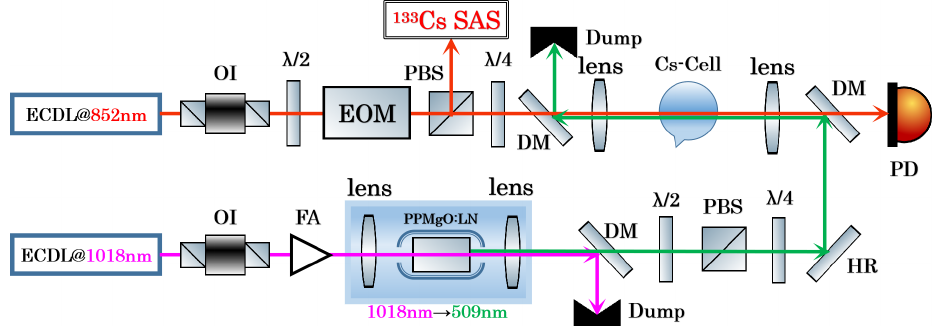
Figure 1. Schematic diagram of the experimental setup.An ECDL at 852 nm is used as a probe laser, and an ECDL at 1018 nm is frequency-doubled and used as a 509-nm coupling laser. The frequency-doubling crystal is a PPLN. A SAS (saturation absorption spectroscopy) setup is used as a frequency reference for the hyperfine structure of the Cs D2 line, where OI is optical isolator; EOM, electro-optic modulator; λ /2, half-wave plate; λ /4, quarter-wave plate; PBS, polarization beam splitter cube; DM, dichroic mirror; FA, fiber amplifier; PD, photodiode (New Focus, model 2051); HR, high reflection mirror; SAS, saturation absorption